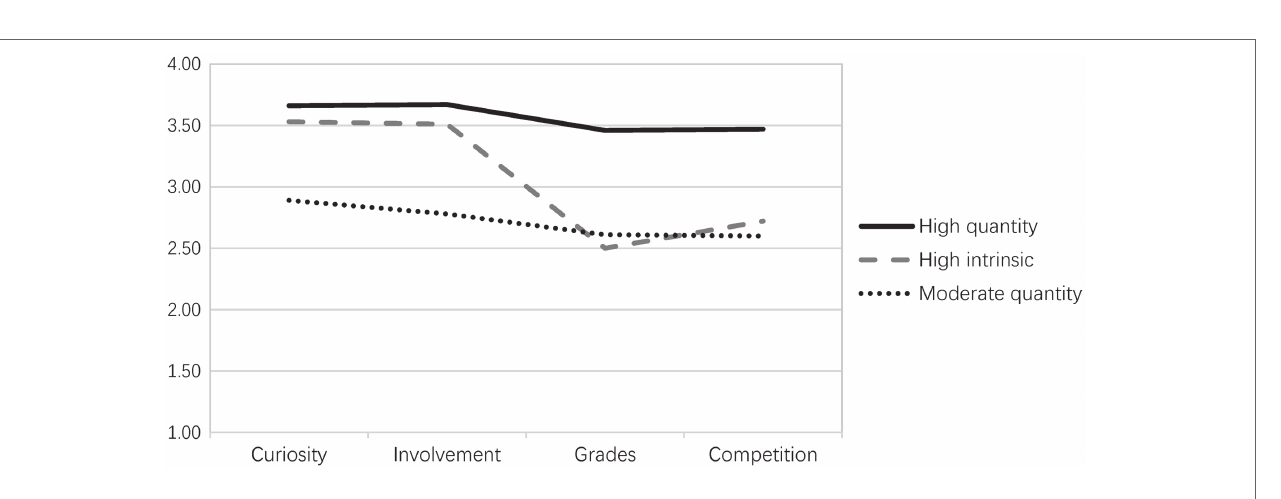
FIGURE 1 | Reading motivation profiles of Chinese